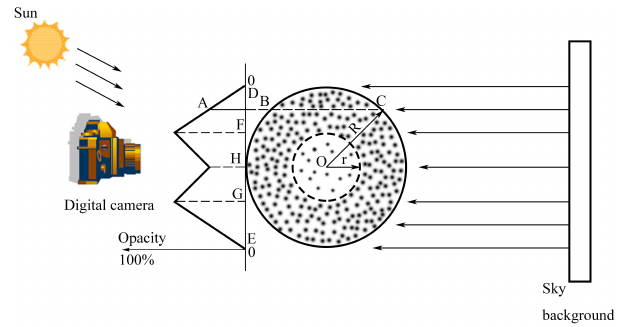
Figure 6. A diagram of DD’s horizontal section model with varia- tion of opacity.